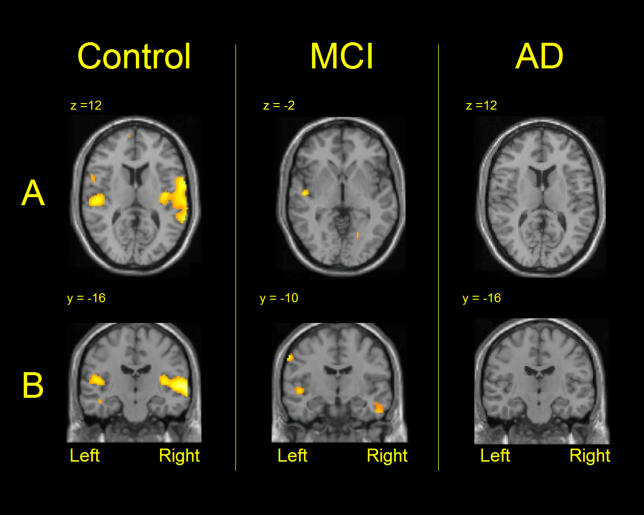
Deactivation in Control Individuals and Patients with MCI and ADResults are superimposed on a standard MRI template. Yellow indicates significant cerebral deactivations during active navigation: (A) axial slices, cranial aspect; (B) coronal slices, dorsal aspect (results are displayed at p < 0.005, for illustration purposes).